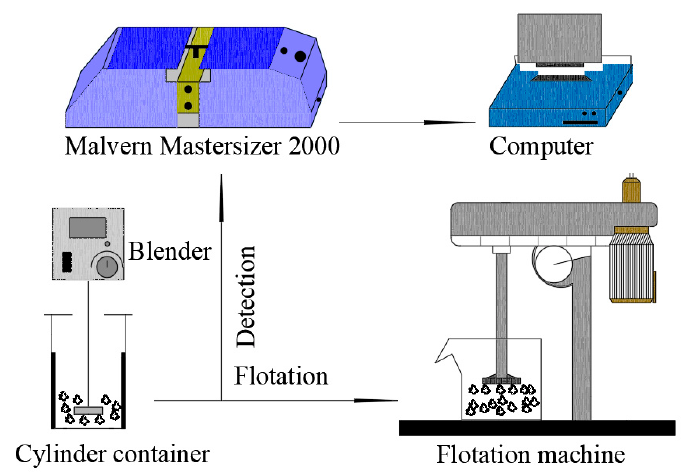
Figure 3. A schematic of the experimental set-up used to determine the flocs properties and flotation performances.